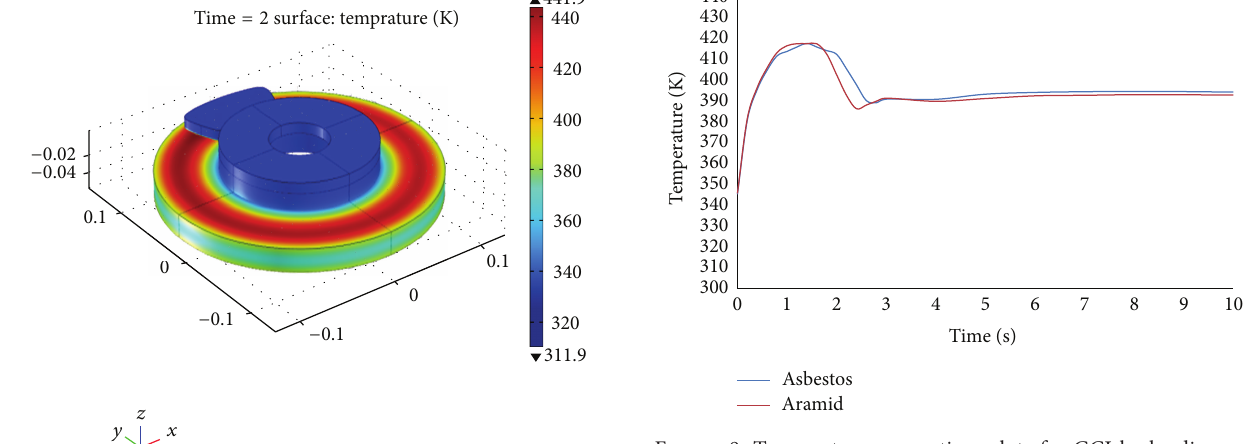
Figure 9: Temperature versus time plots for GCI brake disc and asbestos and aramid brake pads.